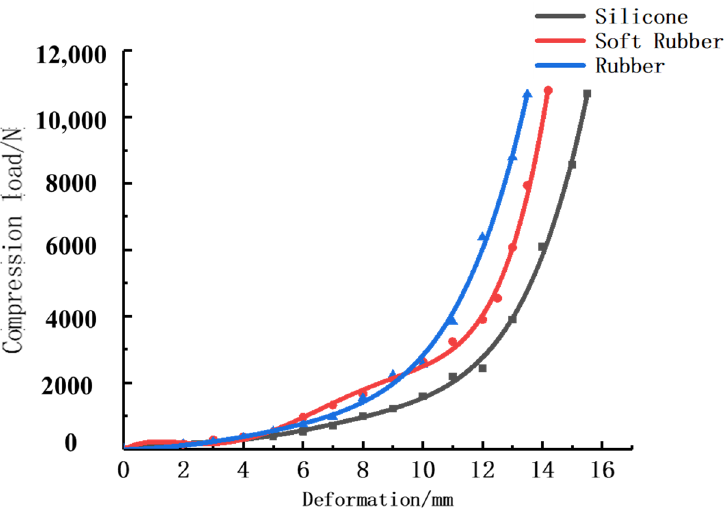
Figure 2. Fitting curve of compression load–displacement.